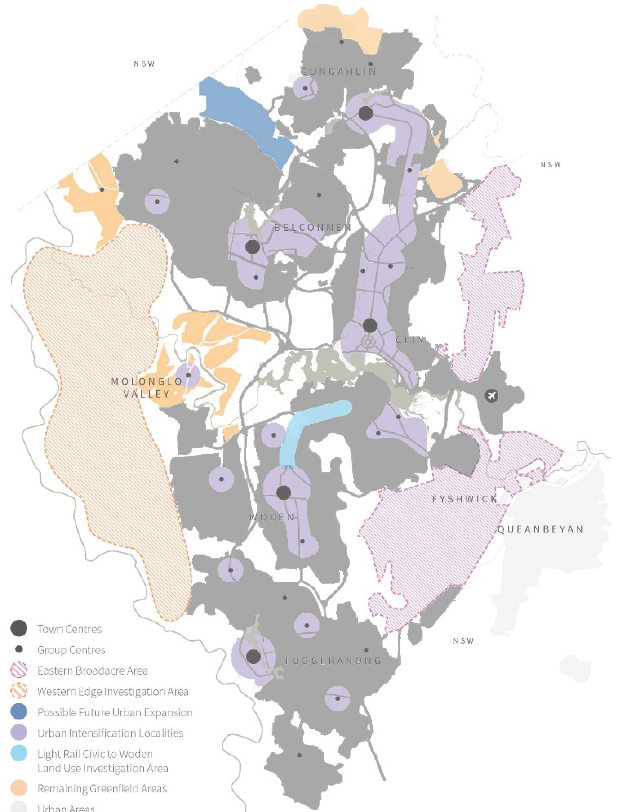
Figure 1. The dark grey colour shows the scattered urban form and the purple colour shows the urban intensification localities. Adapted from Figure L4: Current and future urban growth in the ACT, with permission from Office of the Commissioner for Sustainability and the Environment (2019). Licensed under a Creative Commons Attribution (CC BY 3.0) licence.